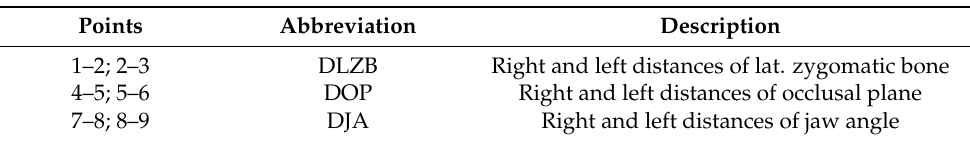
Figure 8. Radiological distances as described in Table 4. These were divided into a left and right part by midfacial plane (red). Ideally the left part of the distance should be as long as the right part. Table 4. Distances between two defined points. Division of each distance results in six linear distance measurements in